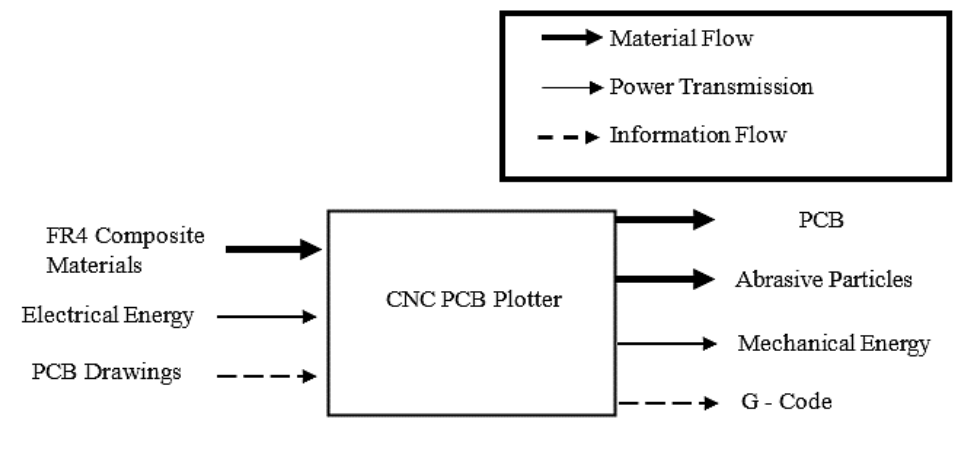
Figure 2. Black box model for CNC PCB plotter.